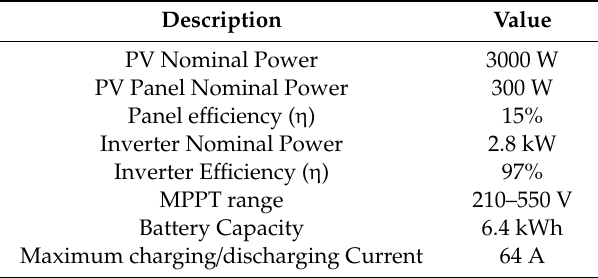
Table 3. Main characteristics of the photovoltaic power plant.